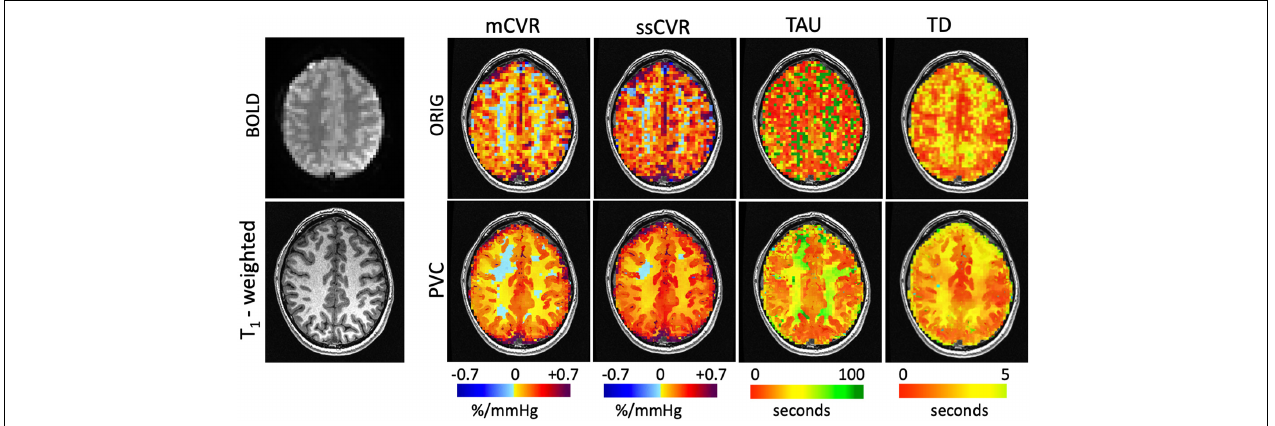
FIGURE 3 | Maps of CVR metrics (mCVR, ssCVR, TAU, and TD) for one subject represented using the original resolution (ORIG) in the first row and processed using the partial volume correction (PVC) in the second row. The raw BOLD image and the high resolution T 1 weighted image are shown in the first column. Using the matter segmentation from the T 1 -weighted high resolution (1 mm isotropic) scan, the original CVR metrics maps of 3.5 mm isotropic resolution (ORIG) were corrected for partial volume effect and mapped onto the 1 mm isotropic grid. TABLE 1 | Average CVR metrics (mCVR, ssCVR, TAU, BAT) within white matter and gray matter vascular territories (Cerebellum, ACA, MCA, and PCA), before and after partial volume correction, in normal healthy subjects. mCVR ssCVR TAU (%/mmHg) (%/mmHg)